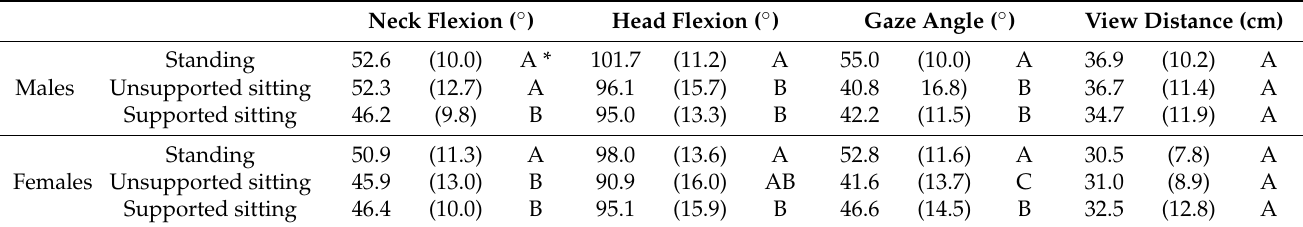
Table 6. Duncan grouping results for various gender and posture